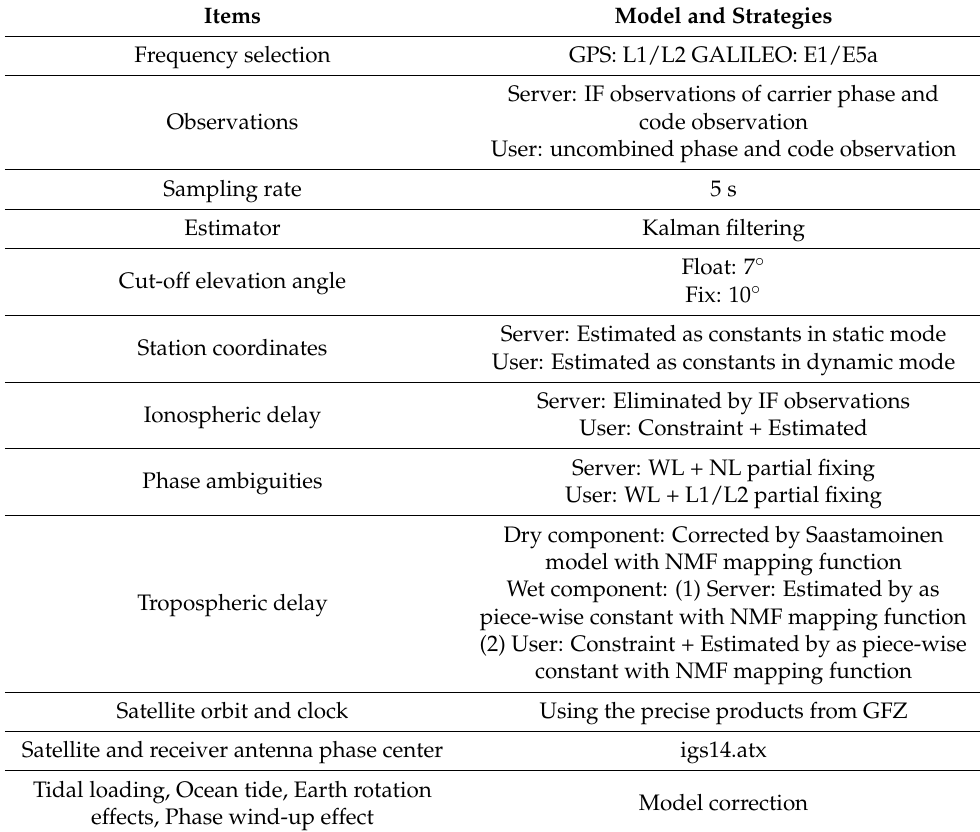
Table 1. Models and strategies that were adopted. Items Model and